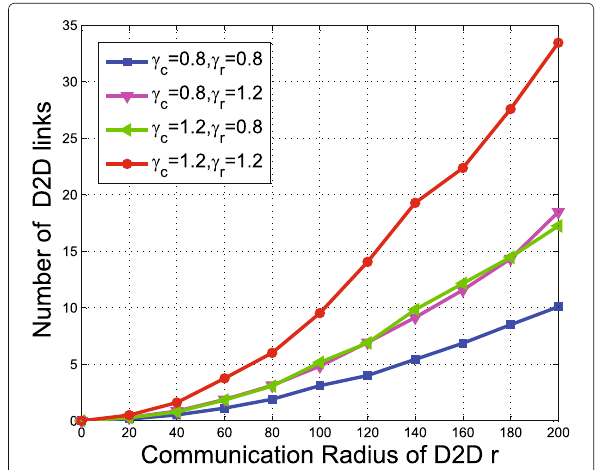
Fig. 6 The average number of D2D links for different request probability and storage probability with N =2000. Illustrates the average number of D2D links versus the collaboration distance r for different γ c and γ r